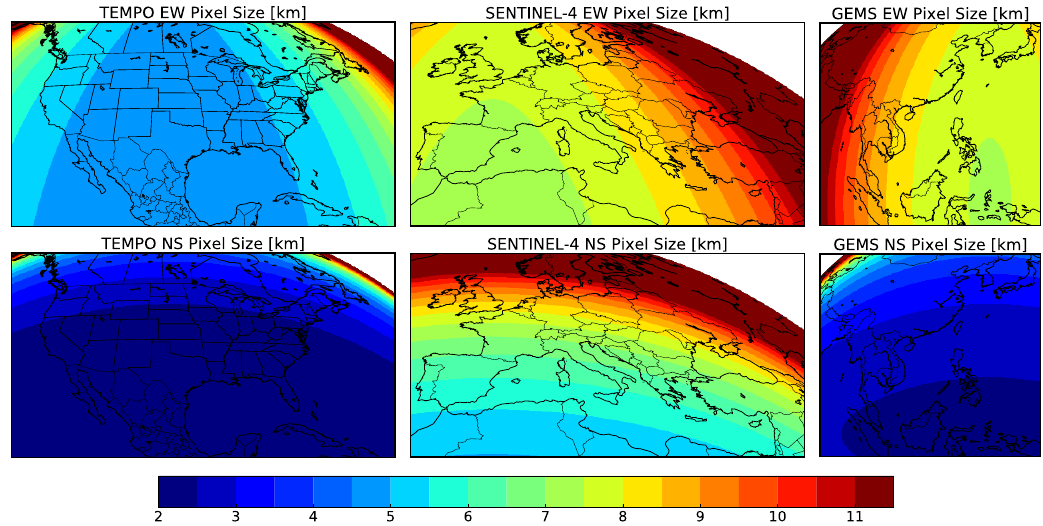
Figure 1. Spatial resolution of TEMPO, SENTINEL-4, and GEMS. Pixel sizes were determined according to a geostationary projection on the globe from the satellites’ respective